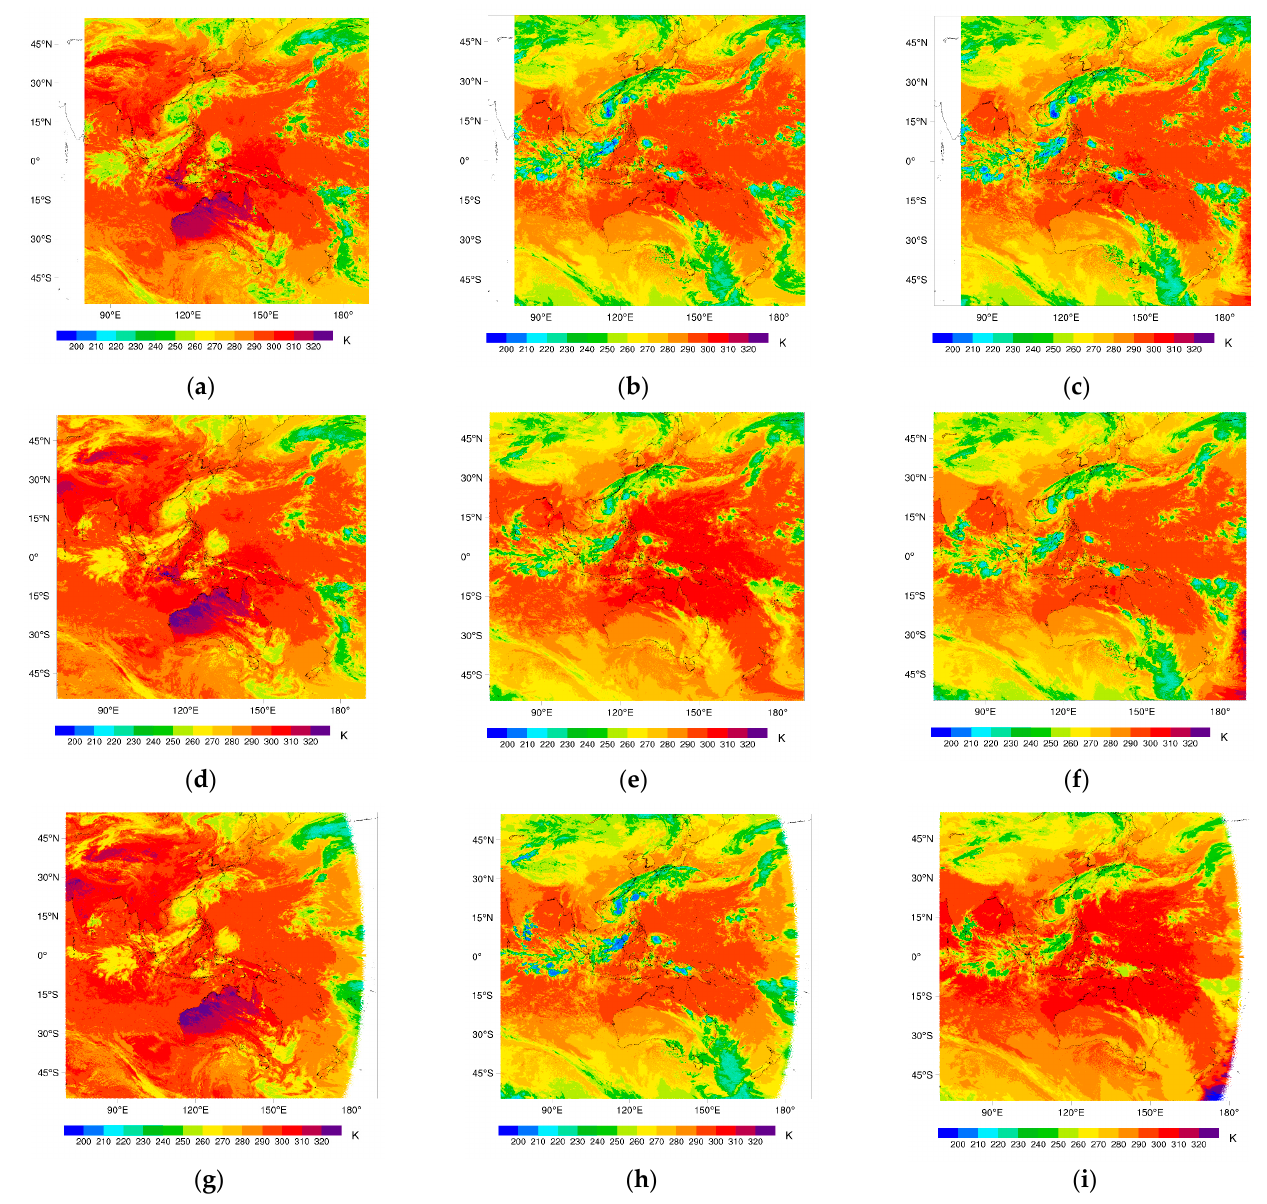
Figure 5. Spatial distribution of ~3.75 μ m brightness temperature for ( a – c ) Himawari-8/AHI, ( d – f ) Fengyun-4B/AGRI and ( g – i ) Fengyun-4A/AGRI ( a , d , g ) at 0600 UTC, ( b , e , h ) 1500 UTC and ( c , f , i ) 1700 UTC on 31 October 2022.